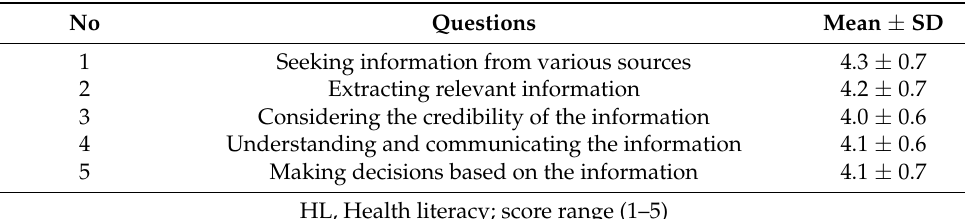
Table A2. Average value of HL